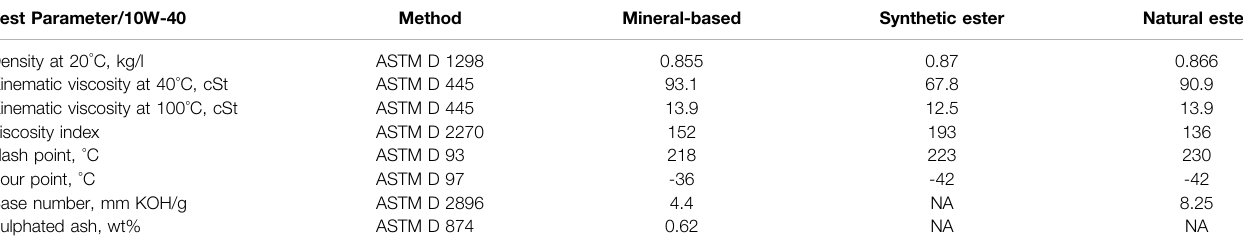
TABLE 5 | Basic physicochemical of mineral oil, natural ester, and synthetic ester for 10W-40 engine application. Test Parameter/10W-40 Method Mineral-based Density at 20 ° C,